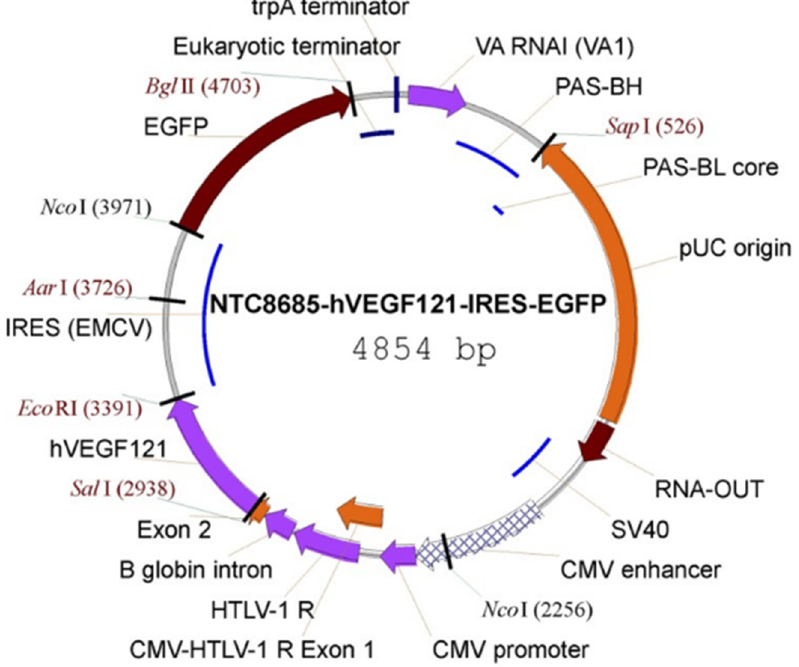
Figure 7. Vector map of the NTC8685–human (h)VEGF 121 –IRES–EGFP. CMV, cytomegalovirus; EGFP, enhanced GFP; HTLV-1, human T-cell leukemia virus type 1; IRES (ECMV), internal ribosomal entry site (from the encephalomyocarditis virus); PAS, primosomal assembly site; PAS-BH, primosomal assembly site sequence on the pBR322 H strand; PAS-BL, primosomal assembly site sequence on the pBR322 L strand; pUC, plasmid University of California; SV, simian virus; trpA, tryptophan A; VA RNAI, virus-associated RNA I, a type of noncoding RNA that plays a role in regulating translation. Reproduced with permission [82].